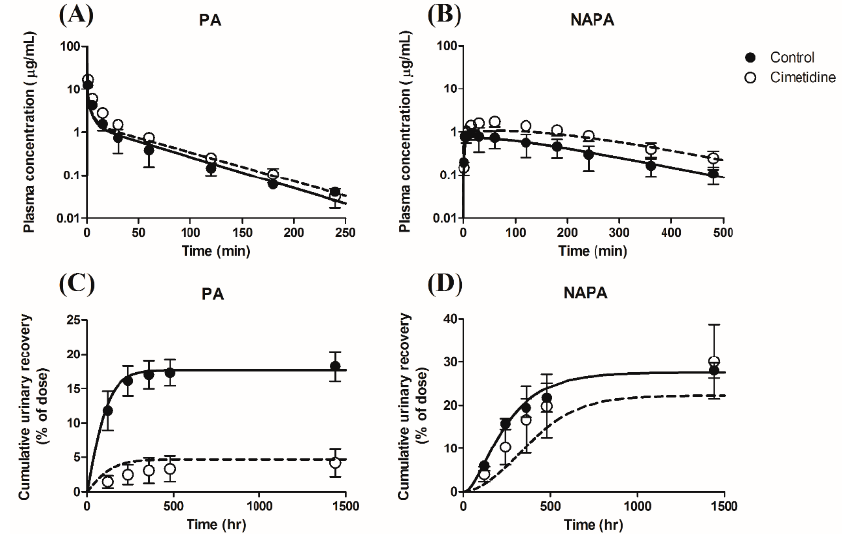
Figure 5. Observed and simulated plasma concentration-time profiles ( A , B ) and urinary excretion profiles (Cumulative urinary recovery (% dose)) ( C , D ) for PA ( A , C ) and NAPA ( B , D ) after intravenous bolus administration of 10 mg/kg of PA HCl in the absence or presence of cimetidine. (Observed results from Figure 2). Closed circles and solid lines represent the observed and simulated (model fitted) results without cimetidine, whereas open circles and dashed lines represent the observed and simulated (predicted) results with cimetidine, respectively. Symbols represent the mean ± S.D.